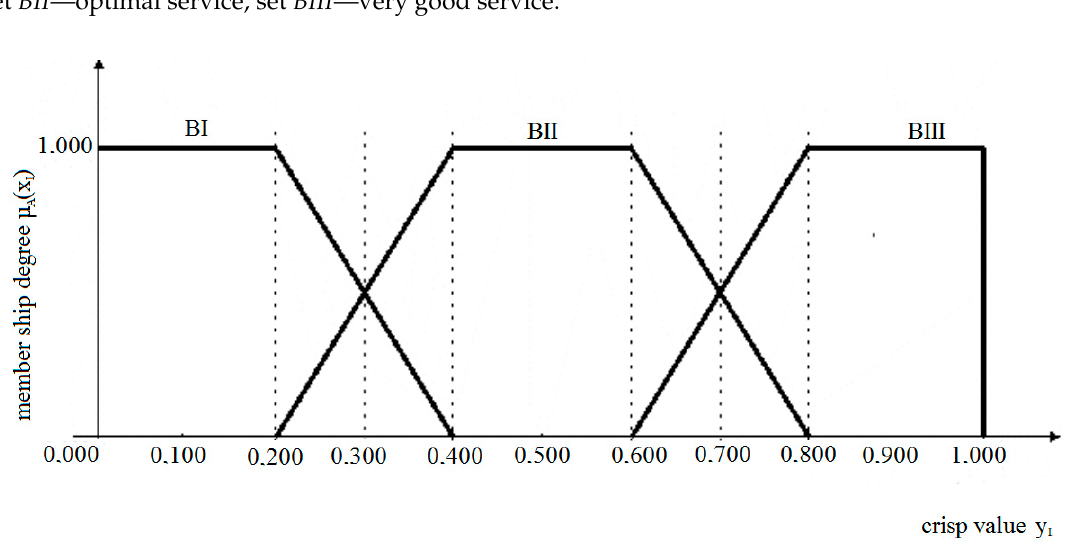
Figure 4. Membership functions of output set B ( y i ).